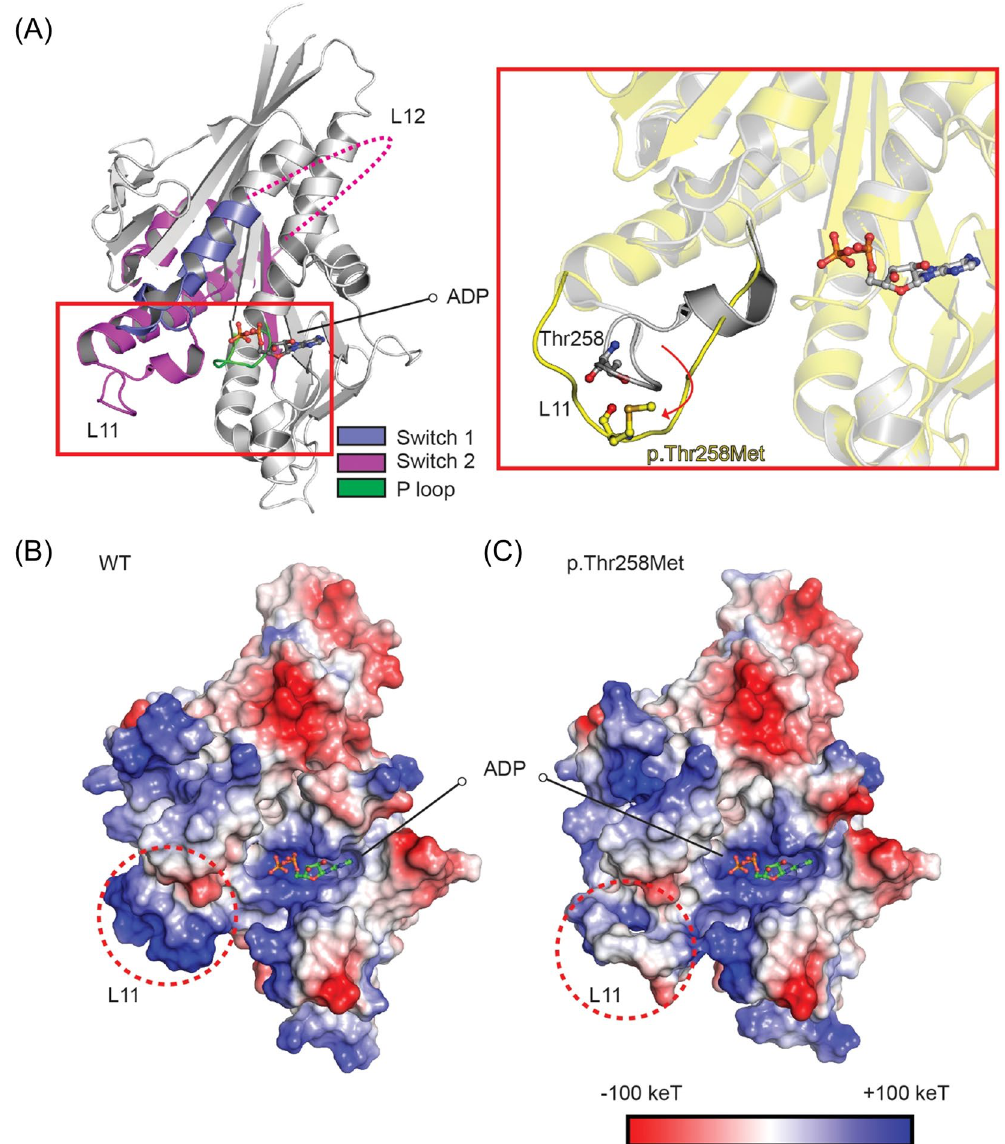
Figure 5. Structural modeling of the KIF1A motor domain with p.T258M mutation. ( A ) Modelled structure of the KIF1A motor domain mutant (p.Thr258Met). The crystal structure of the motor domain from WT KIF1A in complex with ADP [PDB ID: 1I5S] is depicted as a cartoon representation. The ATP binding loop (P-loop), switch-1, and switch-2 are shown in green, deep blue, and purple, respectively. L11 and L12 (unmodelled) in switch-2 are also indicated. The ADP molecule is shown by the ball-and-stick model. The red box indicates a close-up view of the boxed region. The structure of the modelled mutant (p.Thr258Met) motor domain of KIF1A is shown in yellow. The conformational change in L11 predicted to be induced by the p.Thr258Met mutation is indicated by a red arrow, together with the structure of WT L11 shown in grey. ( B,C ) Electrostatic charge distribution patterns in the WT ( B ) and modelled mutant p.Thr258Met ( C ) motor domains of KIF1A, as shown by the surface model. Negative and positive charges are shown in red and blue, respectively. The regions of charge changes (L11) are indicated by red dotted